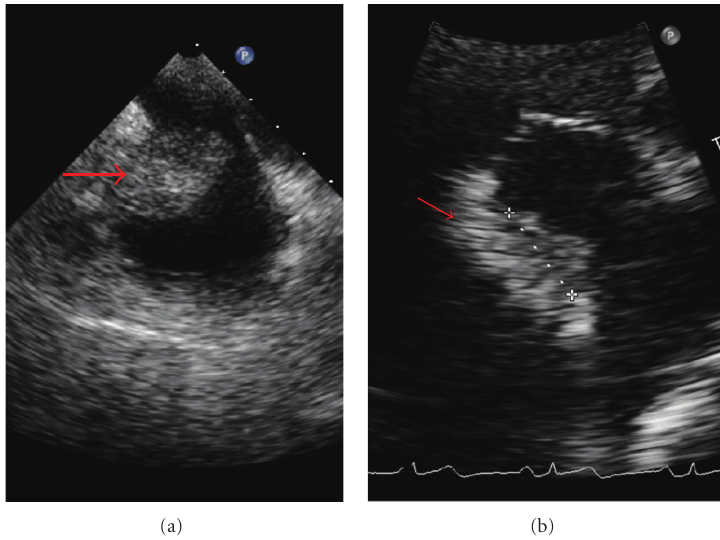
Figure 2: (a) Shows CRAT at presentation (b) shows CRAT after one week of anticoagulation.